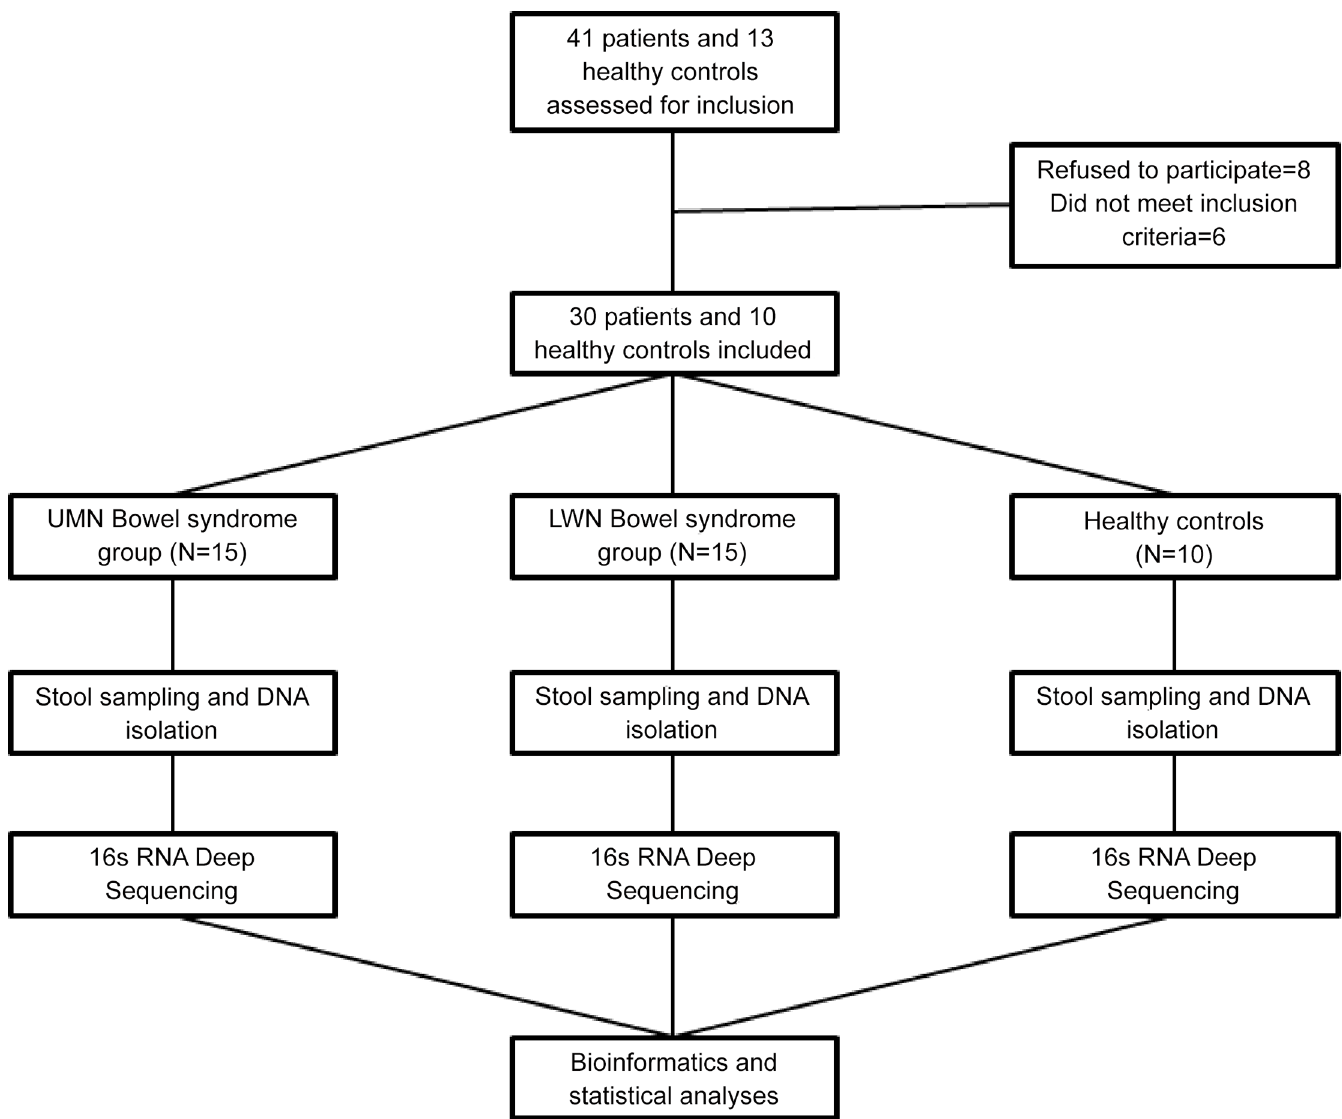
Fig 1. Flow diagram of the study design (UMN: Upper motor neuron, LMN: Lower motor